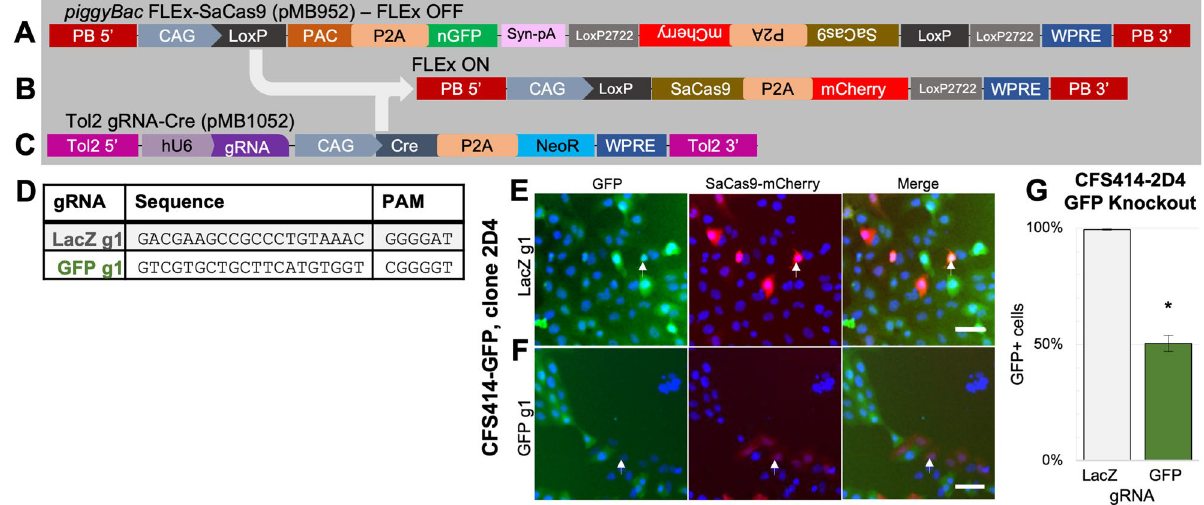
Figure 6. Knockout of GFP in CFS414 cells using SaCas9. ( A ) The pMB952 piggyBac transposon plasmid is a FLEx-cassette vector for Cre-conditional expression. Under constitutive expression, the CAG promoter expresses PAC puromycin resistance gene, with a P2A cleavage peptide sequence and nuclear GFP (nGFP). ( B ) In the presence of Cre, the PAC-nGFP sequence is excised and SaCas9-P2A-mCherry is flipped for sense expression under the CAG promoter. ( C ) The pMB1052 Tol2 transposon plasmid is for Cre-mediated expression of SaCas9 in pMB952-integrated cells, with the delivery of a DNA-targeting gRNA. ( D ) gRNAs used to target GFP or LacZ genes with respective protospacer adjacent motif (PAM) listed. ( E–G ) The monoclonal GFP + cell line CFS414-GFP clone 2D4, transfected with piggyBac transposase, pMB952, and pMB1051 with ( E ) LacZ or ( F ) GFP gRNAs. ( G ) Percent of cells in LacZ and GFPg1 groups expressing GFP post-selection. * denotes significance from a two-tailed t-test, p < 0.05. Error bars denote SEM. Abbreviations: PB 5’ and 3’, piggyBac transposon sites; bGH pA, bovine growth hormone polyadenylation site; Syn pA, synthetic polyadenylation